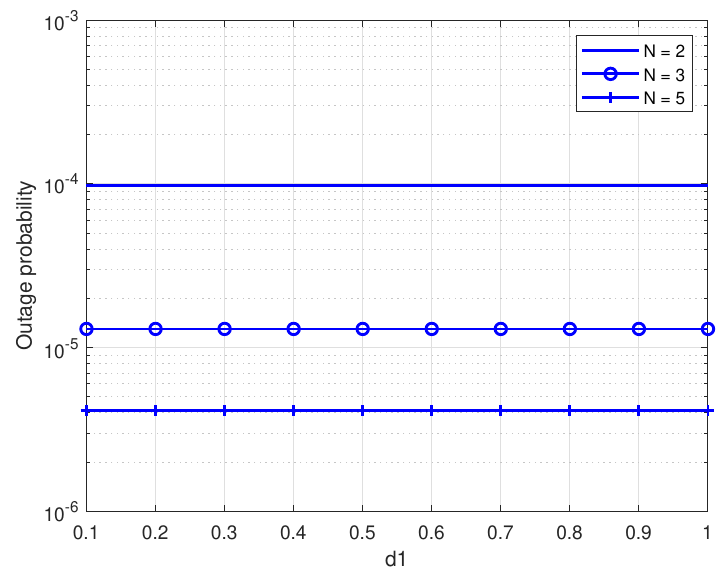
Figure 6. Outage probability versus d 1 ( ¯ γ = 20 dB, Γ th = 5 dB).